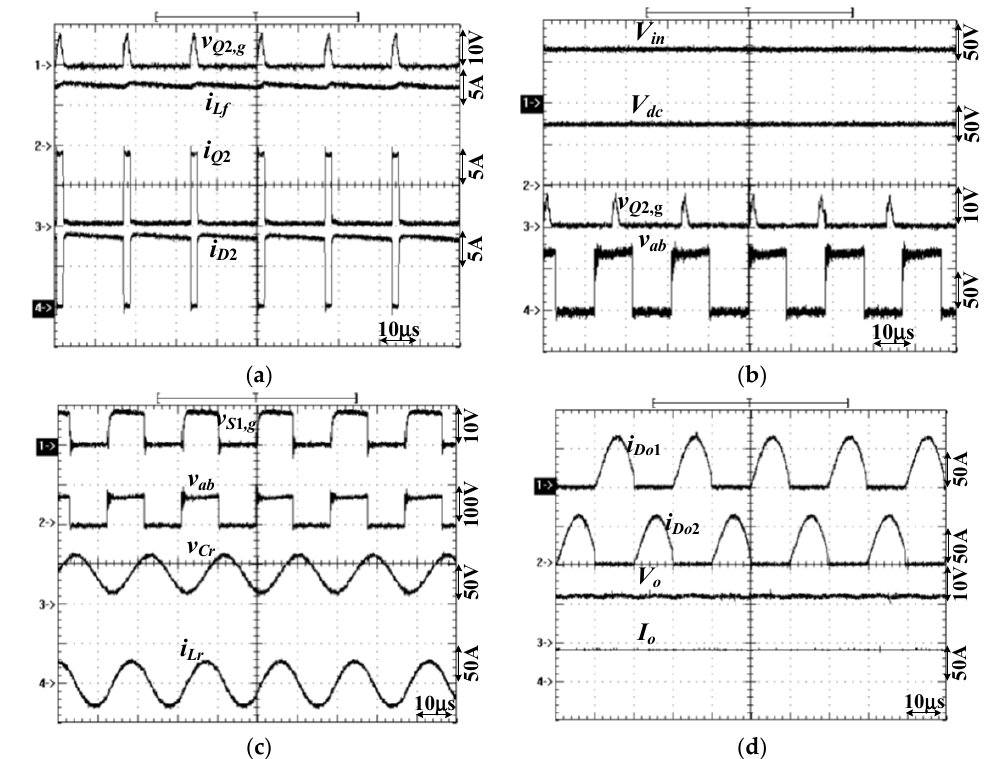
Figure 7. Measured results at V in = 65 V and P o = 500 W ( a ) v Q 2, g , i Lf , i Q 2 and i D 2 ( b ) V in , V dc , v Q 2,g and v ab ( c ) v S 1, g , v ab , v Cr and i Lr ( d ) i Do 1 , i Do 2 , V o and I o .